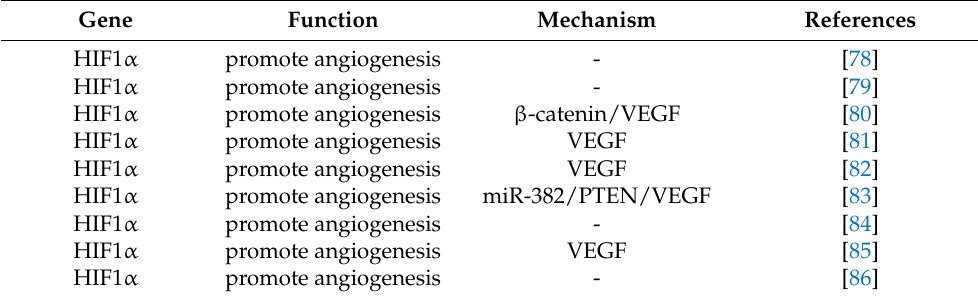
Table 5. HIF regulates gastric cancer progression by gastric cancer cell angiogenesis.